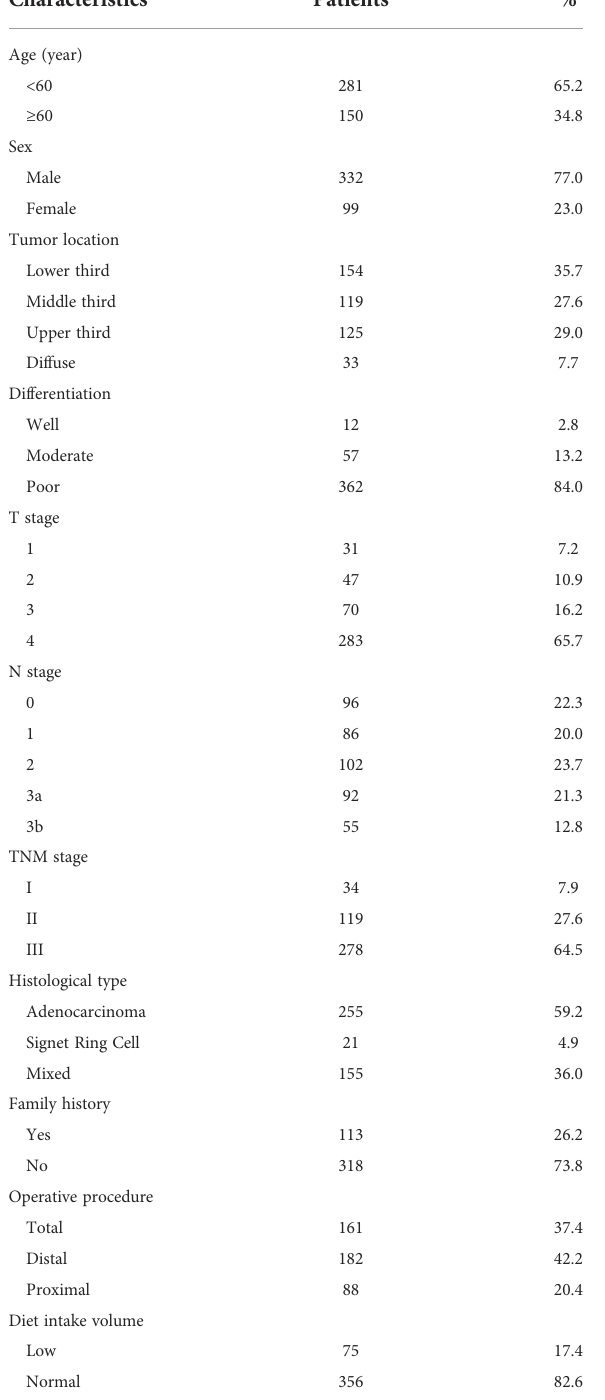
TABLE 1 Clinicopathological characteristics in the 431 gastric cancer patients.